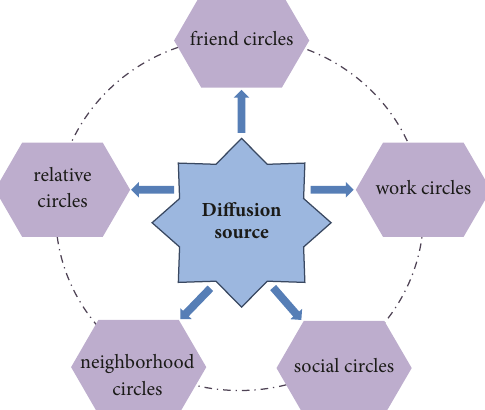
Figure 2: Diffusion media and diffusion path of health food safety scare behavior.